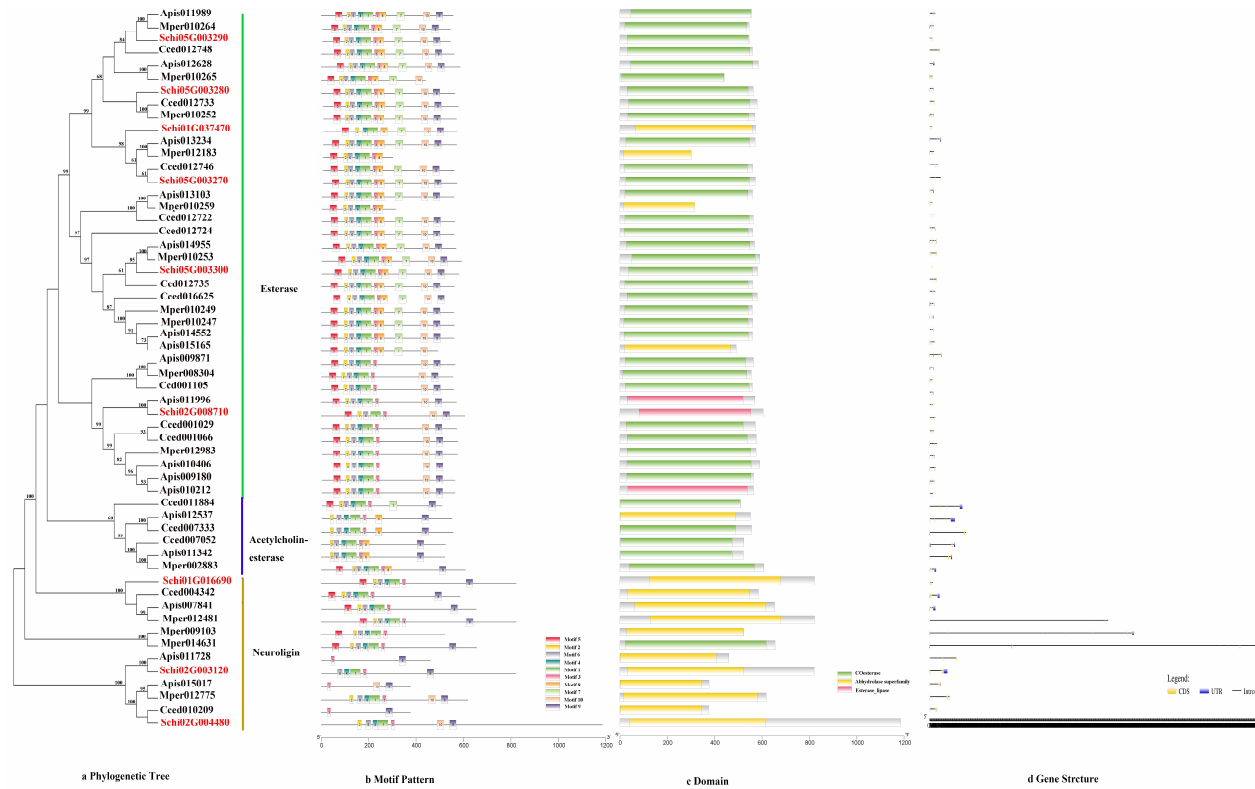
Figure 3. ( a ) Phylogenetic relationships, ( b ) conserved motifs, ( c ) domains and ( d ) gene structures of detoxification genes of the CCE gene family in S. chinensis , A. pisum , C. cedri , and M. persicae .